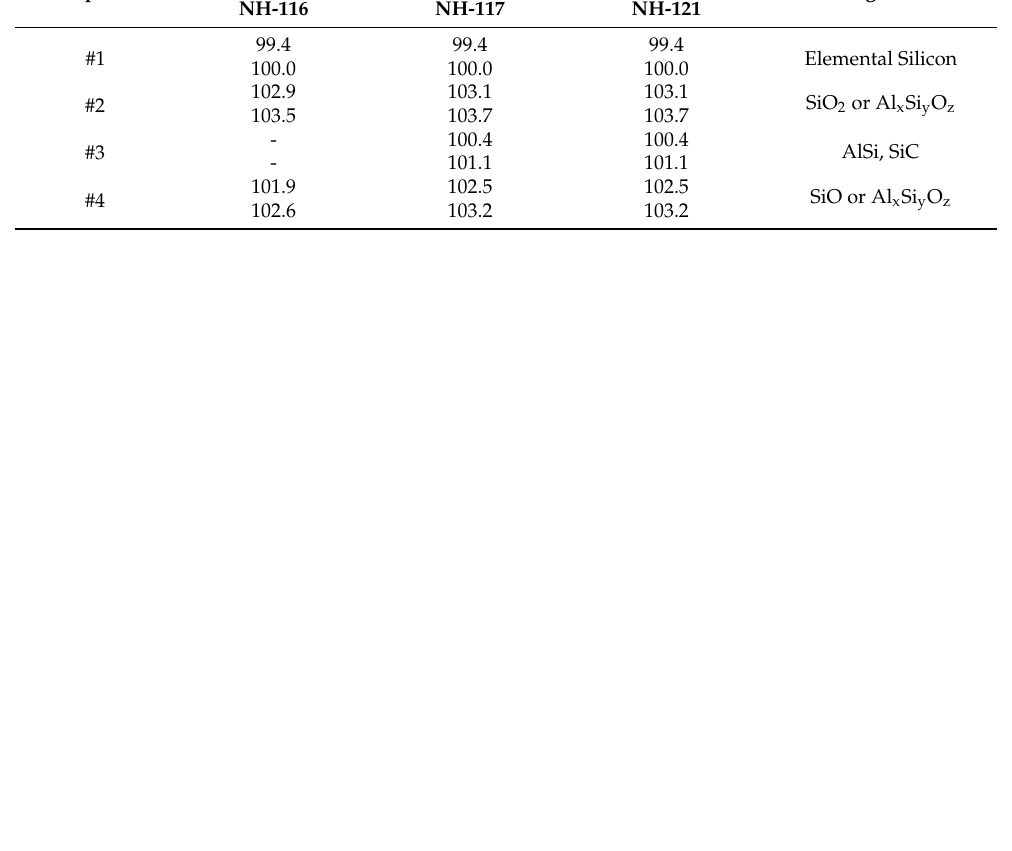
Table 2. Si 2p core line binding energies and their assignment for the different silicon species. Peak Position Si Species